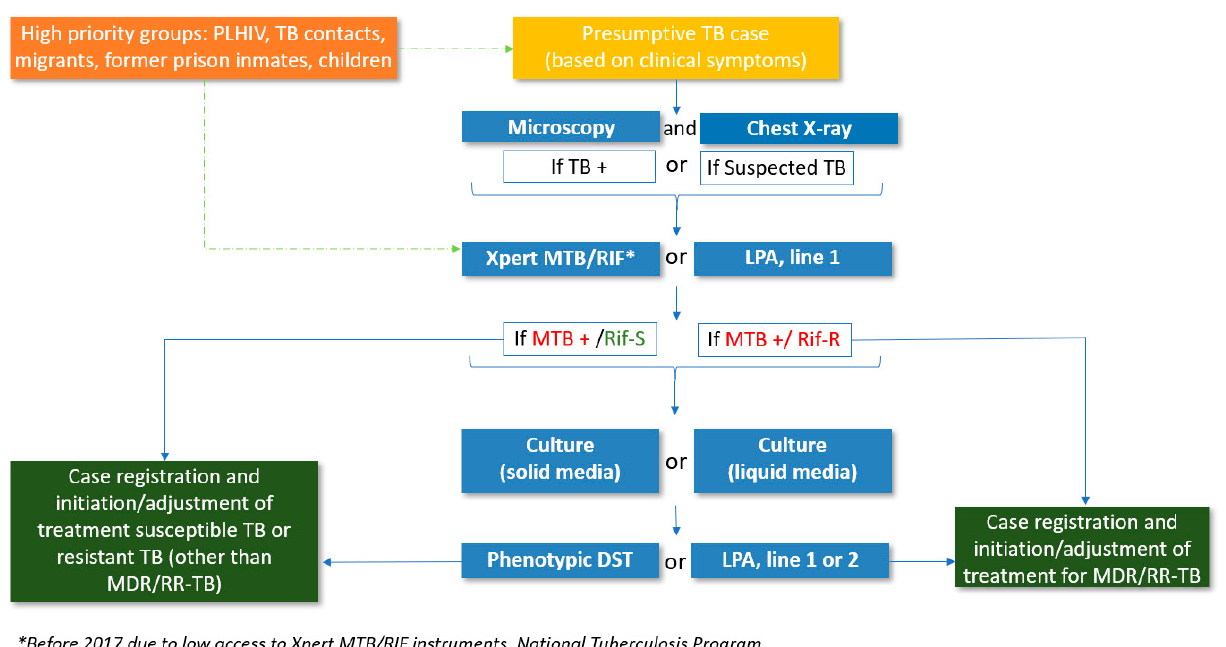
Figure 1. Diagnostic algorithm of people with presumptive TB, Uzbekistan, 2018. TB = tuberculosis, PLHIV = people living with HIV, TB + = smear-positive TB, LPA = line probe assay, MTB = mycobacterium tuberculosis , Rif-S = rifampicin-susceptible, Rif-R = rifampicin-resistant, DST = drug susceptibility testing, MDR/RR-TB = multidrug-resistant/rifampicin-resistant TB.